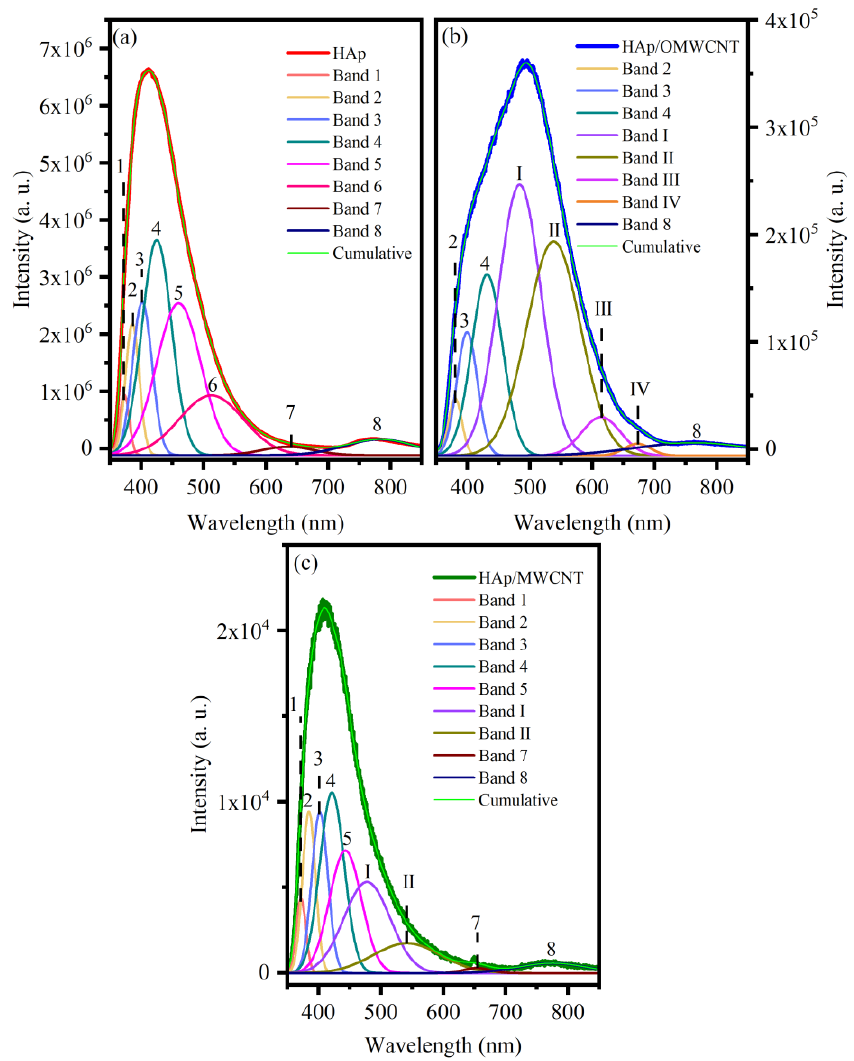
Figure 8. Photoluminescence spectra deconvolution of the HAp ( a ), HAp/OMWCNT ( b ), and HAp/MWCNT ( c ) samples. Table 4. Photoluminescence emission bands of the HAp and composite